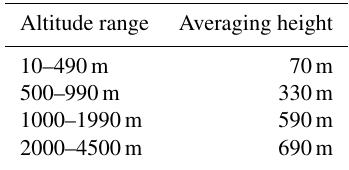
Table 1. Averaging heights by height range used on aerosol backscatter profiles for cluster and wavelet methods.